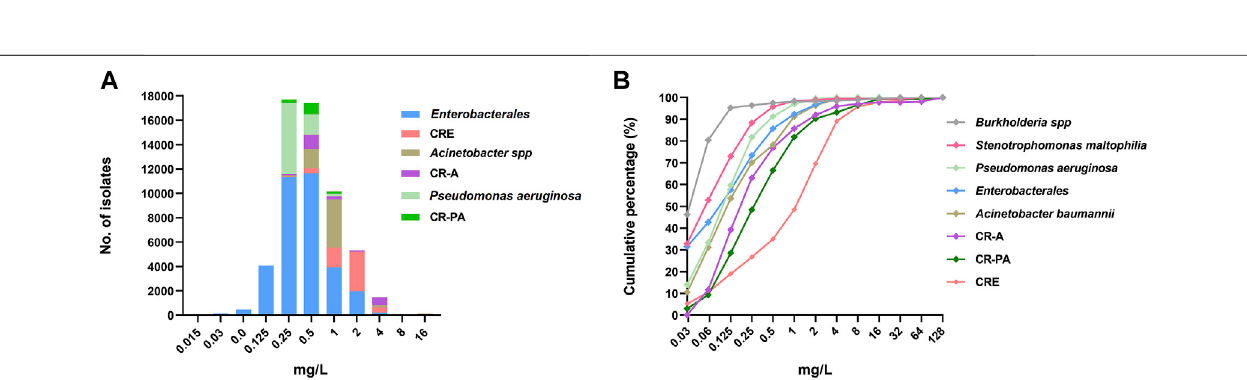
FIGURE 3 | The ce fi derocol MIC pro fi le of Enterobacterales , Acinetobacter spp and Pseudomonas aeruginosa with or without carbapenem-resistance. (A) , the MIC 90 distributionofthethreeGram-negativebacteria; (B) ,thecumulativecurvesofMICsof9305isolates(n=13).CRE,carbapenem-resistant Enterobacterales ;CR-A, carbapenem-resistant Acinetobacter spp ; CR-PA, carbapenem-resistant P. aeruginosa .